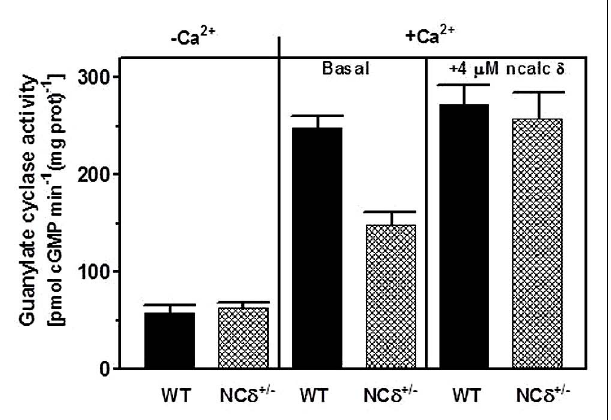
FIGURE 5 | NC δ modulates ROS-GC1 activity in mouse testes. Testes were removed from the wild type (WT) and NC δ + / − mice and their particulate fractions were isolated in the presence of 100 μ M Ca 2 + .These were assayed for guanylate cyclase activity in the presence of 1 mM EGTA or 10 μ M Ca 2 + (panel “ − Ca 2 + ”- and “ + Ca 2 + ”-basal). 4 μ M myristoylated NC δ was added to the membranes and the guanylate cyclase activity was assessed in the presence of 10 μ M Ca 2 + .The experiment was done in triplicate and repeated with separate membrane preparations.The results are mean ± SD of these